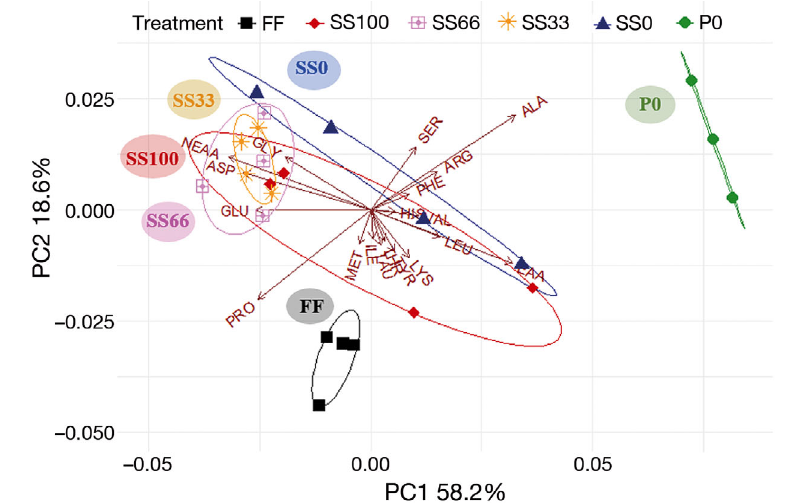
Fig. 4. PCA of amino acids, including essential (EAA) and nonessential amino acids (NEAA) (% of the total amino acids), in Hediste diversicolor fed differ- ent feeds over an experimental period of 30 d. Data were arcsine transformed. See Table 1 for treatment definitions; P0: field-collected polychaetes